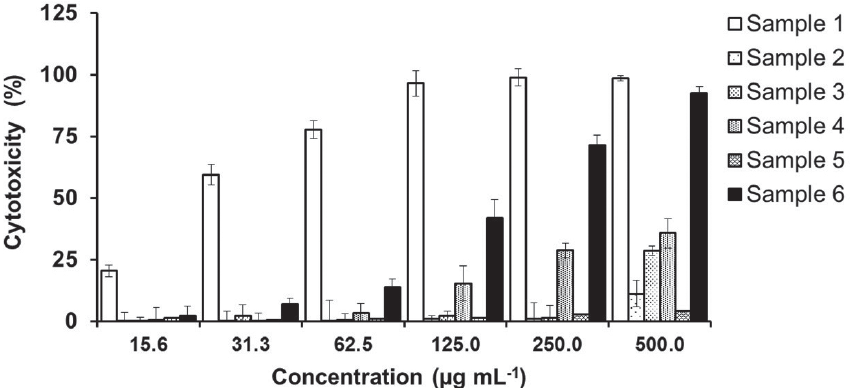
FIGURE 5 - Cytotoxic e ffects of commercial available aqueous extracts of Tribulus terrestris (Samples 1 to 5) and the aqueous extract of the aerial parts of Tribulus terrestris (Sample 6) evaluated against the normal fibroblasts cell line (L929). Values represent the percentage of cell death ± SD of three independent experiments tested by the MTT